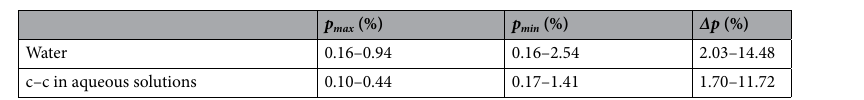
Table 1. Measurement accuracies of p max , p min , and (cid:31) p for water and calcium carbonate in aqueous